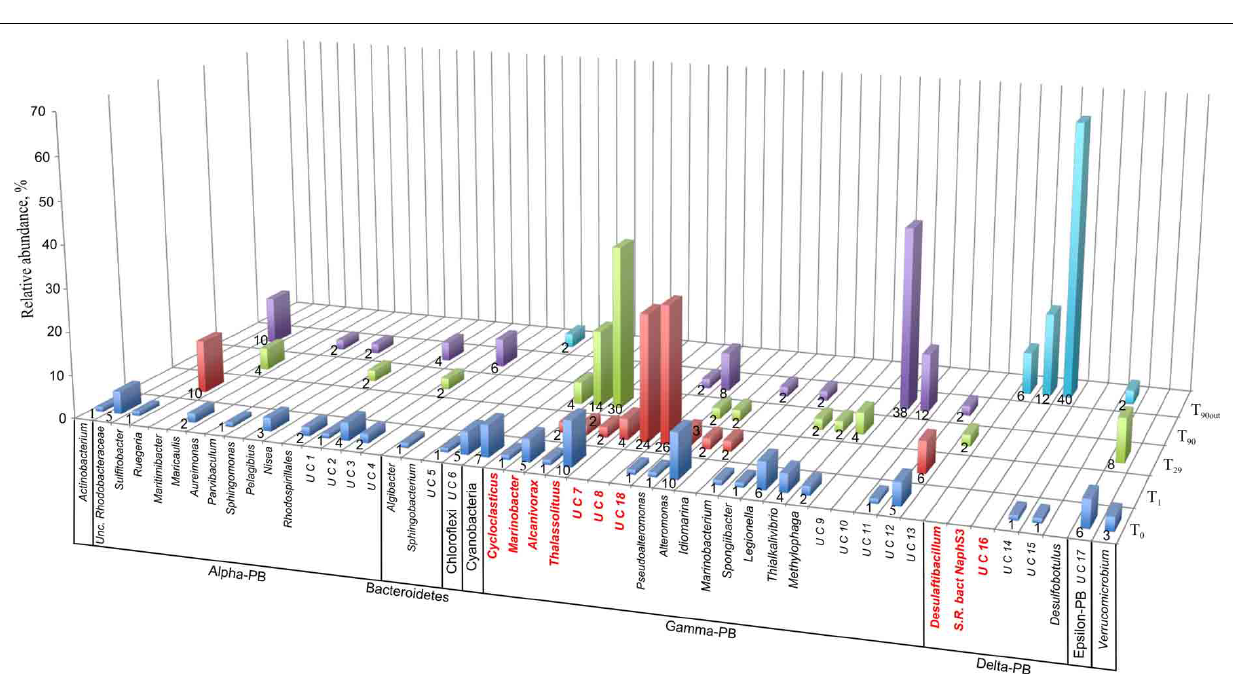
FIGURE 5 | Dendrogram representation of taxonomic analysis of 16S crDNA clones retrieved from five libraries. The numbers at the base of columns represent the percentage of clones in corresponding